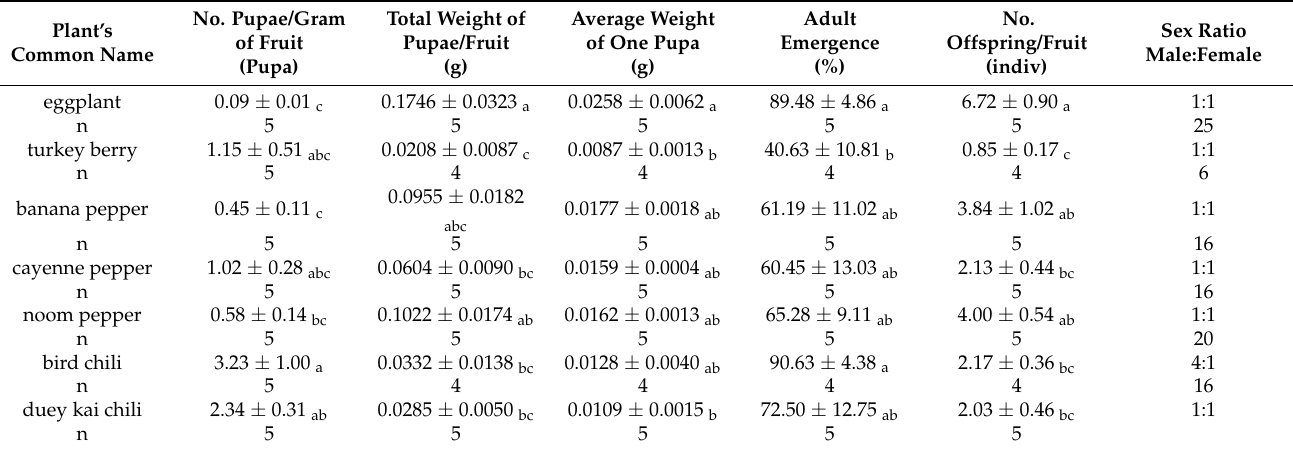
With the exception of sex ratio, n = the number of replicated cohorts. With the exception of the number of pupae per gram of fruit, uninfested fruit (pupae were not found) was not used as replicate in other parameters. Sex ratio samples were number of infested fruit with emerged B. latifrons offspring. Values (mean ± SE) in the same column followed by different letters are statistically different (Tukey test, p < 0.05). Significance is based on log (x + 1) transformed data, but non-transformed data are